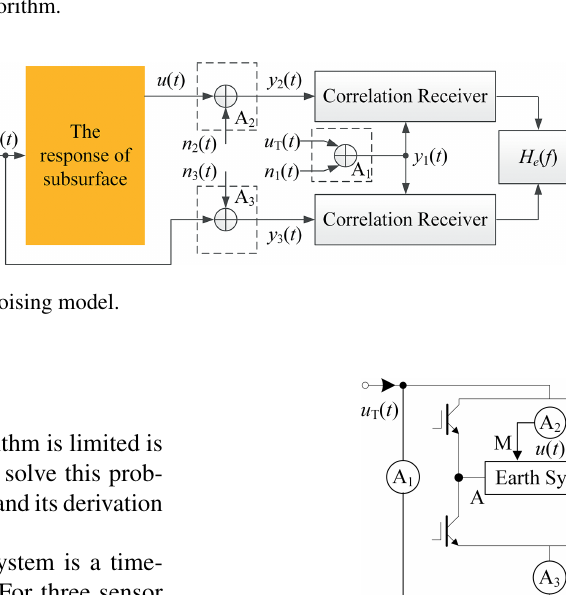
Figure 2. Schematic diagram using the TSIP algorithm.